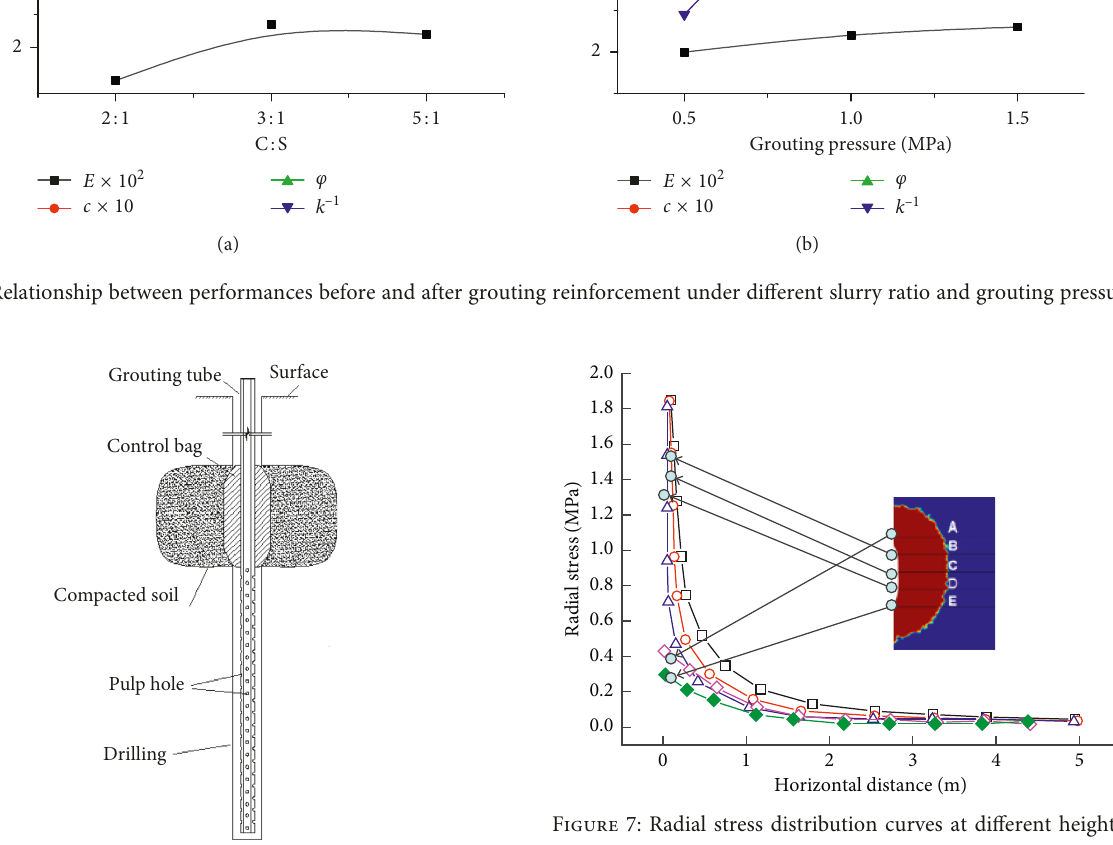
Figure 5: Diagram of control